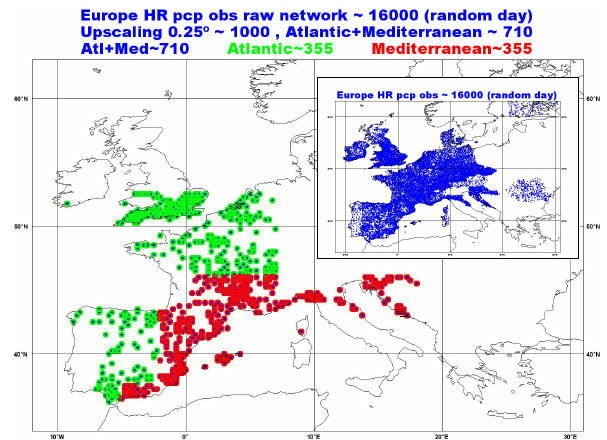
Figure 1. A random day observation locations (blue points in the smaller map) for raw 24-hour precipitation data from High Resolution networks over Europe provided by ECMWF and the corresponding up-scaling to 0.25ºx0.25º longitude and latitude boxes when at least five observations are available, for Mediterranean area (red boxes) and Atlantic area (green boxes).